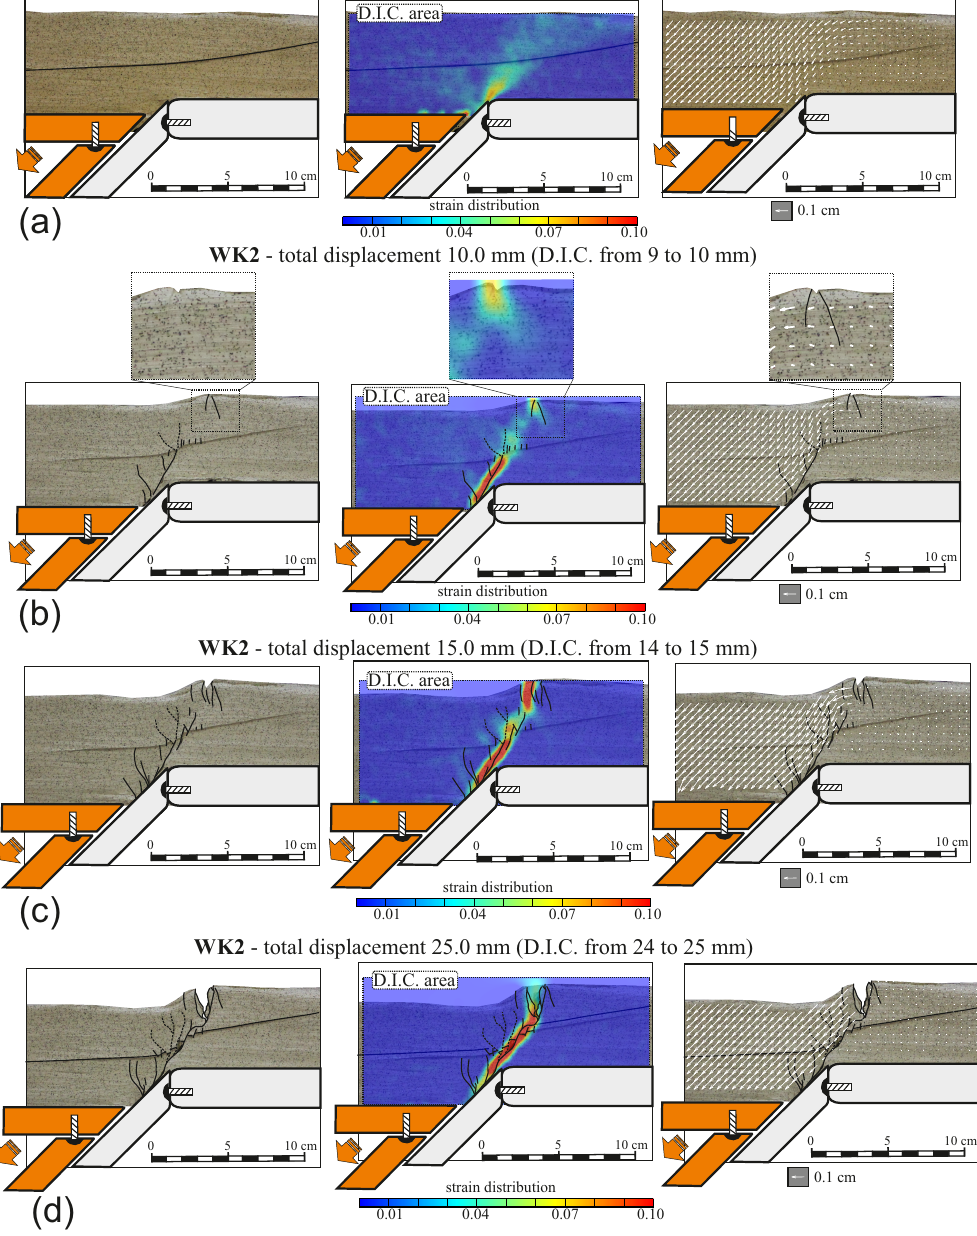
Figure 8. Progressive evolution of the fault patterns in the WK2 wet clay experiment (left panels). For each step the brittle and ductile deformations have been analyzed using the DIC technique, which returned the displacement field (right panels) and the strain distribution (central panels). Dashed lines indicate precursor